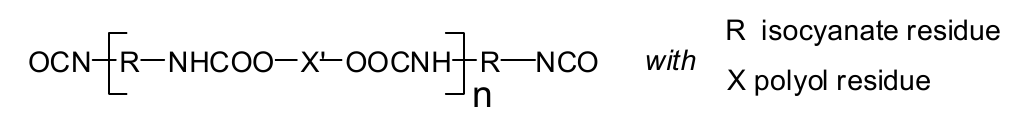
Scheme 6. Schematic representation of monocomponent PUR.